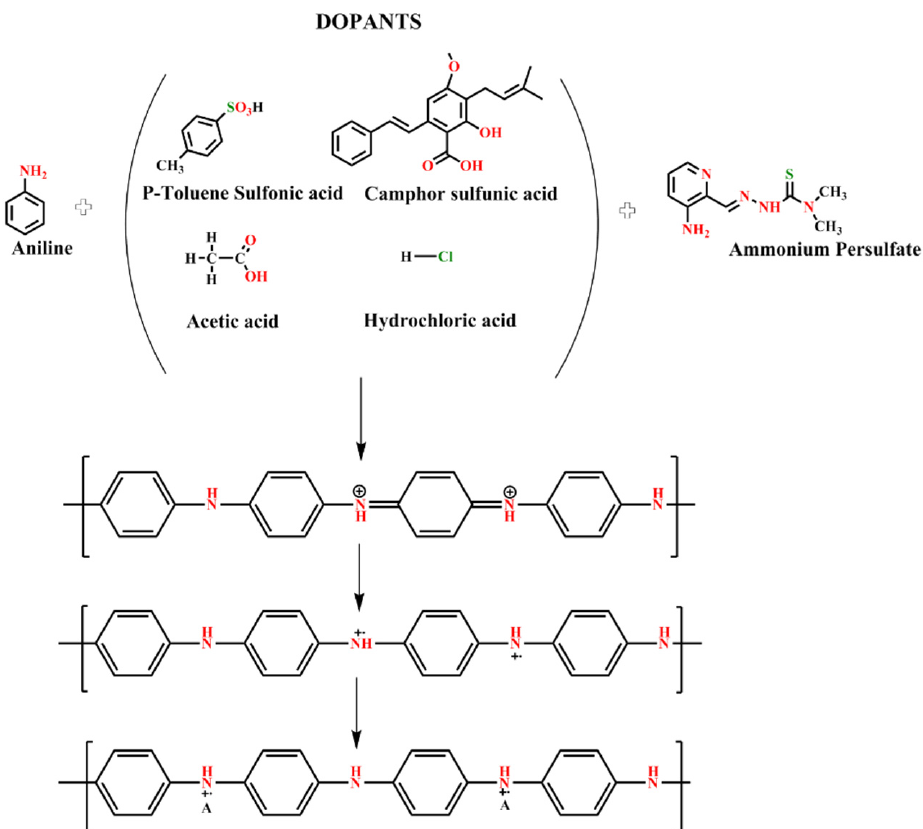
Figure 1. Synthesis of PANI by using different acids as dopants.